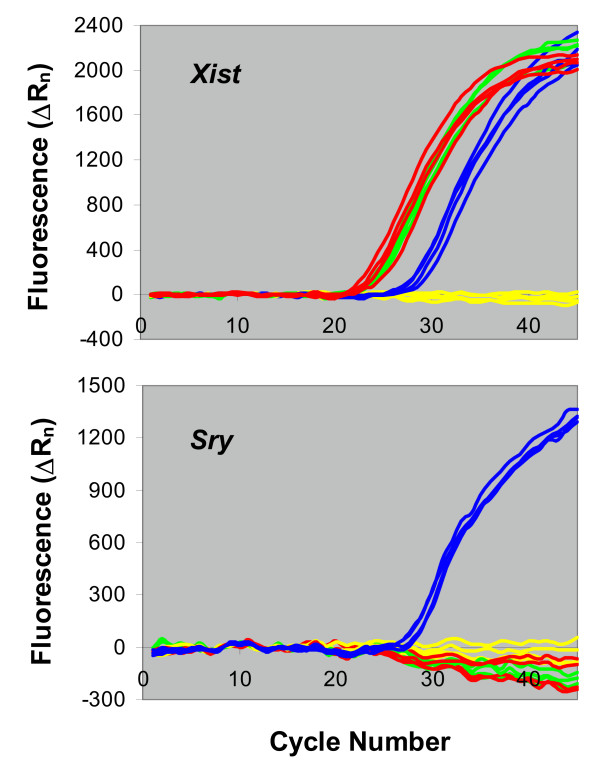
Introduction of a DNase step within the single-tube PurAmp protocol for Xist/Sry quantification. Effect of DNase digestion on Xist (upper panel) and Sry (lower panel) template copy numbers measured in male and female single embryos at the morula stage. Male embryos: blue, non-treated; yellow, DNase-treated. Female embryos: red, non-treated; green, DNase-treated. The DNase enzyme displayed full activity under the conditions tested, as shown by the absence of genomic DNA in treated male samples and detailed in the text.